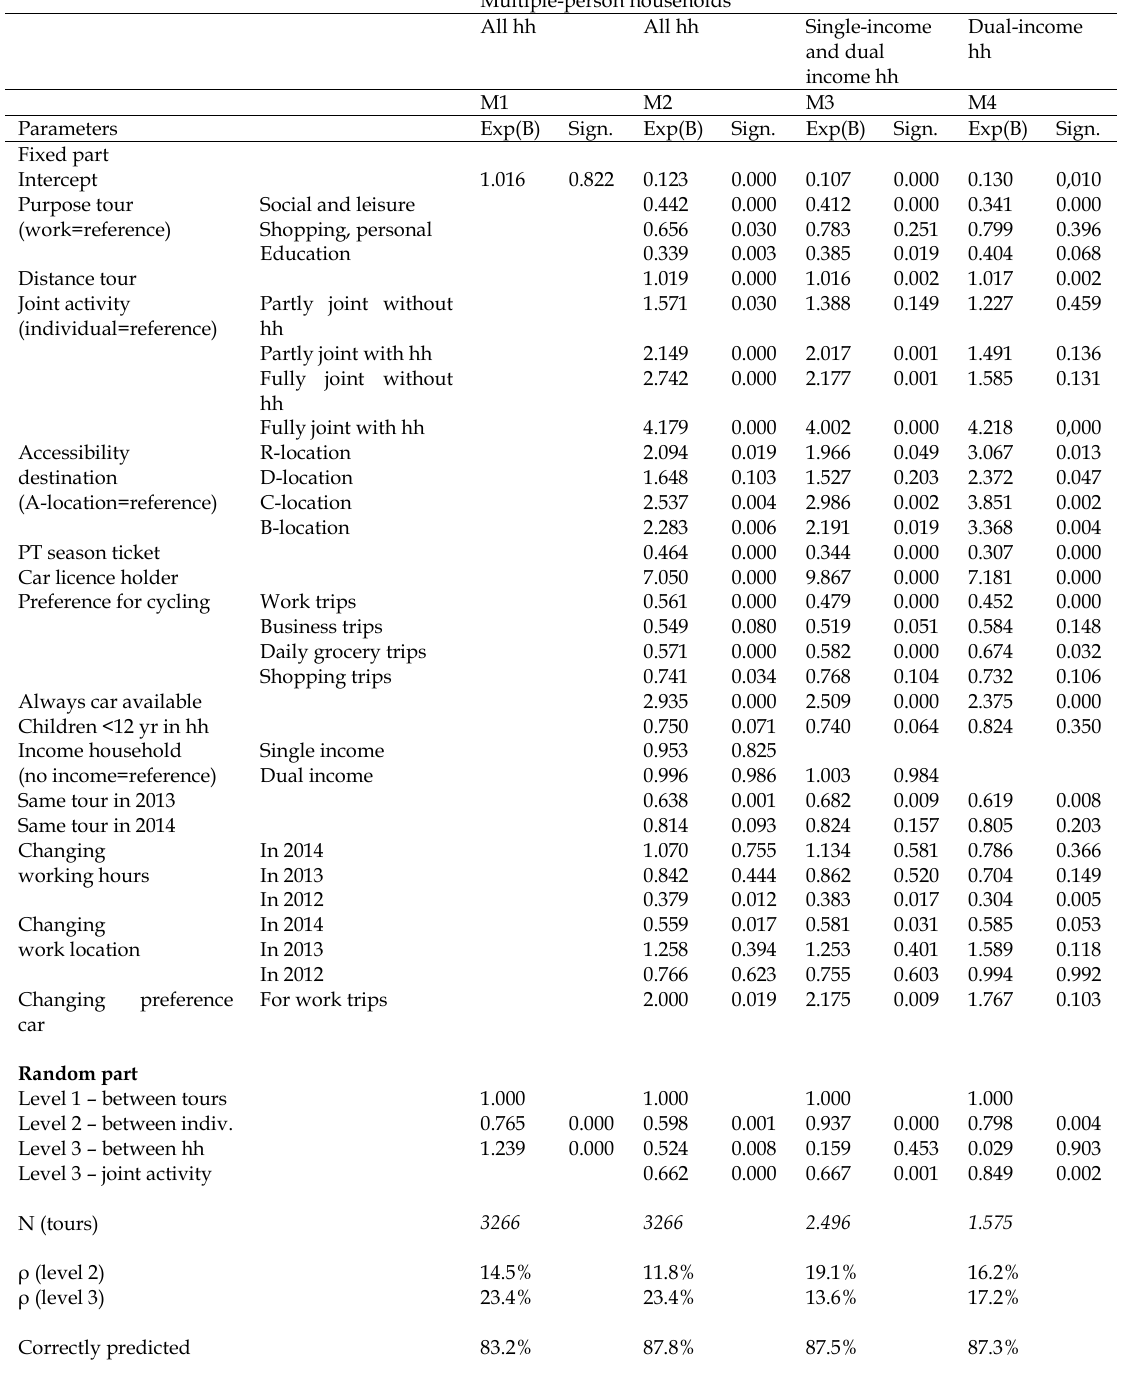
Table 6. Binary choice modelling